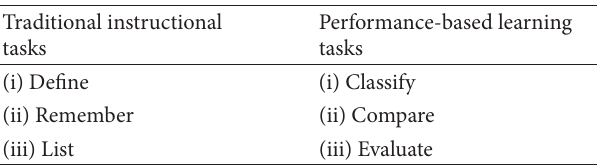
Table 1: Comparison between traditional instruction and perfor- mance-based learning tasks. Traditional instructional Performance-based